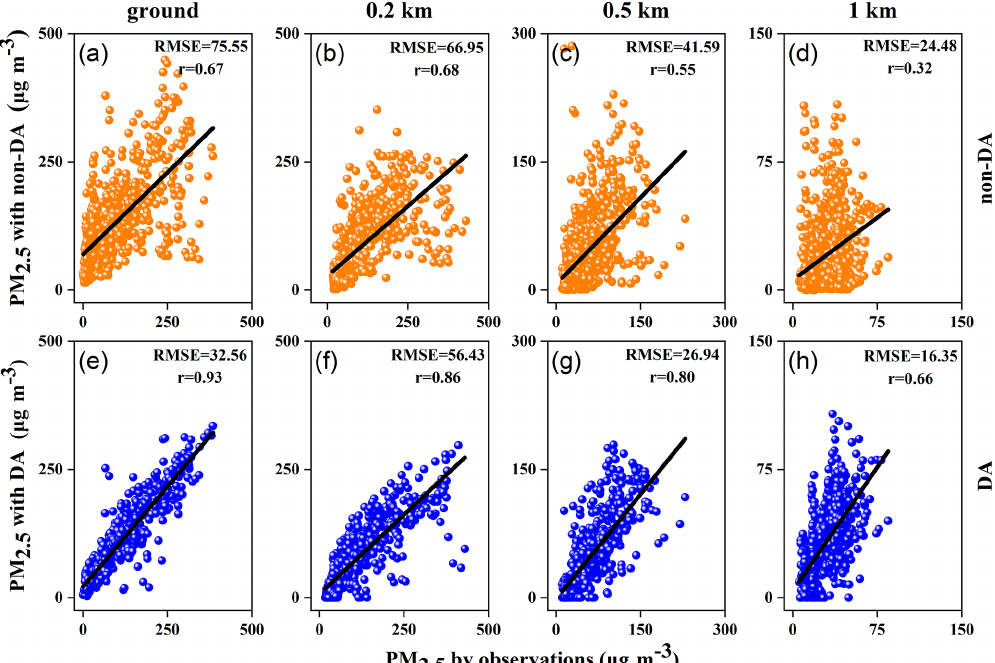
Figure 2. PM 2 . 5 mass concentration comparison results from lidar at different heights (b–d, f–h) and surface observations (a, e) with non- assimilation simulations (a–d) and assimilation simulations (e–h)